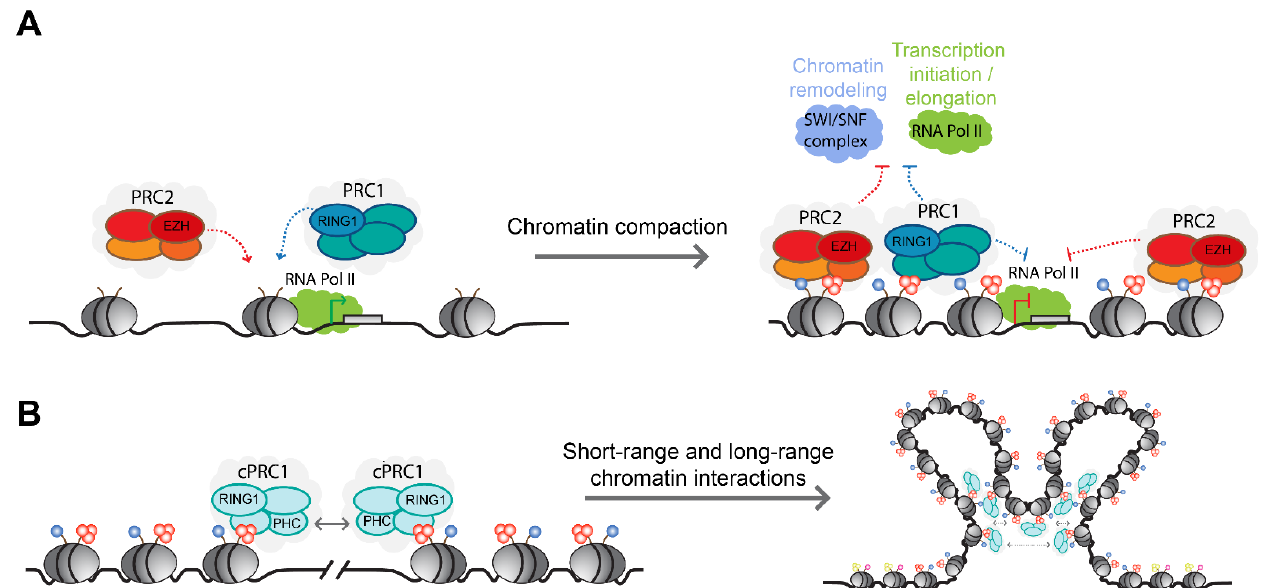
Figure 3. Transcriptional regulation by polycomb complexes. ( A ) Schematic illustration of polycomb-mediated transcriptional repression. Polycomb activity affects transcription at multiple levels, by compacting chromatin and limiting accessibility of chromatin remodeling complexes and transcription factors, as well as by blocking and interfering with RNA Pol II activity. ( B ) Polymerization activity by the SAM domain of the cPRC1 subunit PHC, which promotes chromatin looping and long-rang interactions that contribute to the transcriptional silencing and stable genomic binding of polycomb complexes.